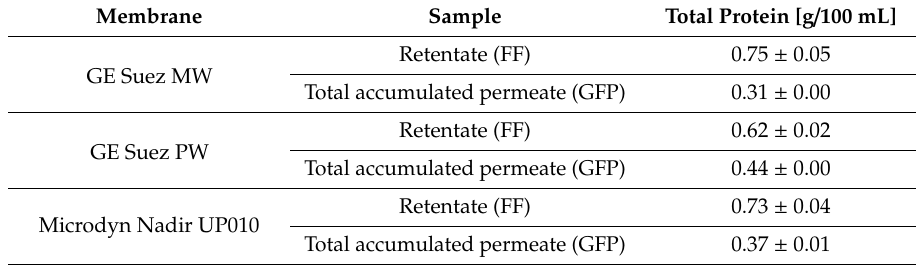
Table 4. Composition of the retentates and permeates of the pre-treated codfish in terms of their content in proteins / peptides by Kjeldahl method. Results are given in g per 100 mL of sample.